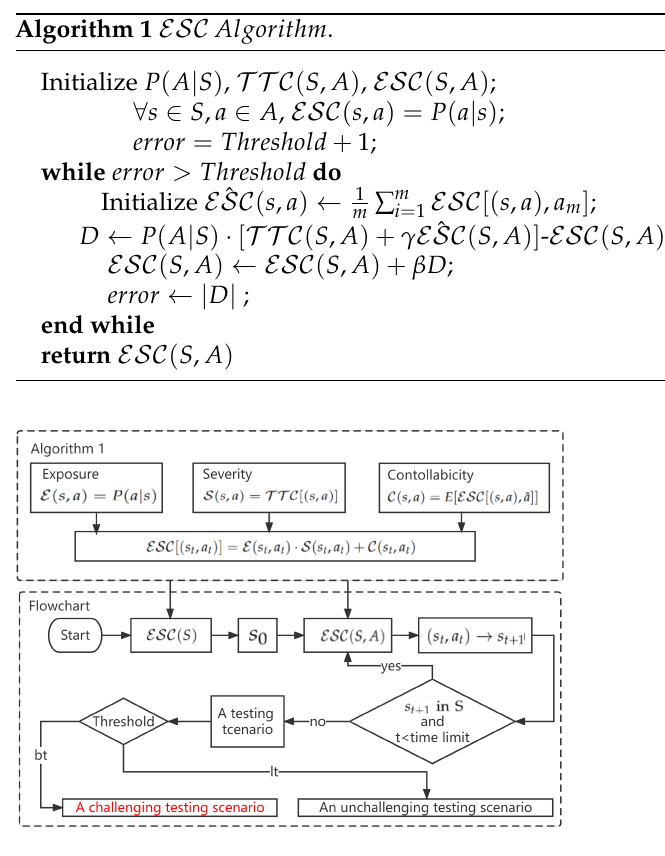
Figure 3. The flowchart of the proposed